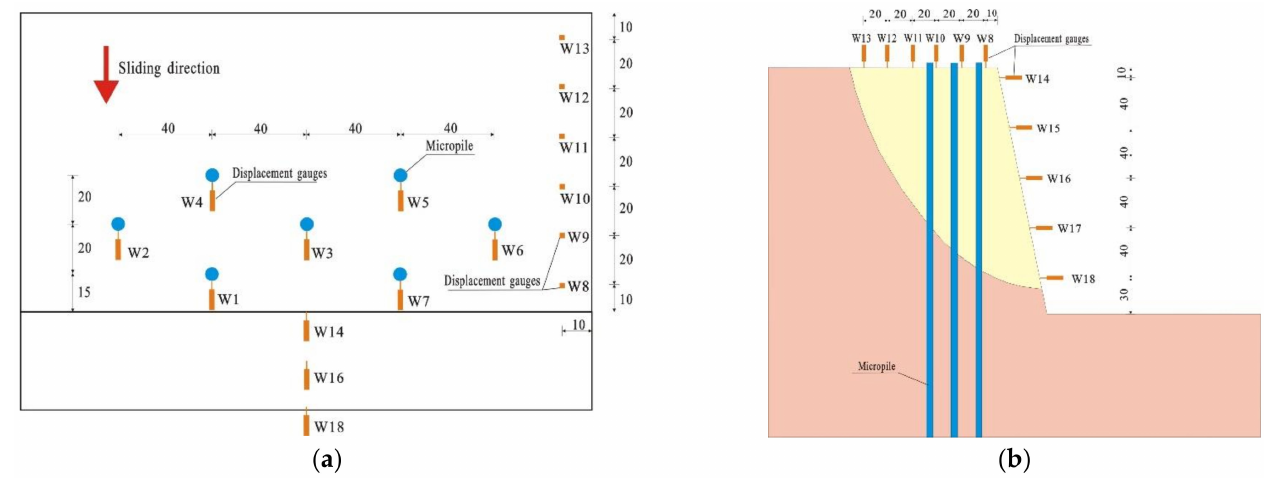
Figure 7. The layout of displacement gauges: ( a ) plan view of the displacement gauge arrangement (unit: cm); ( b ) sectional view of the displacement gauge arrangement (unit: